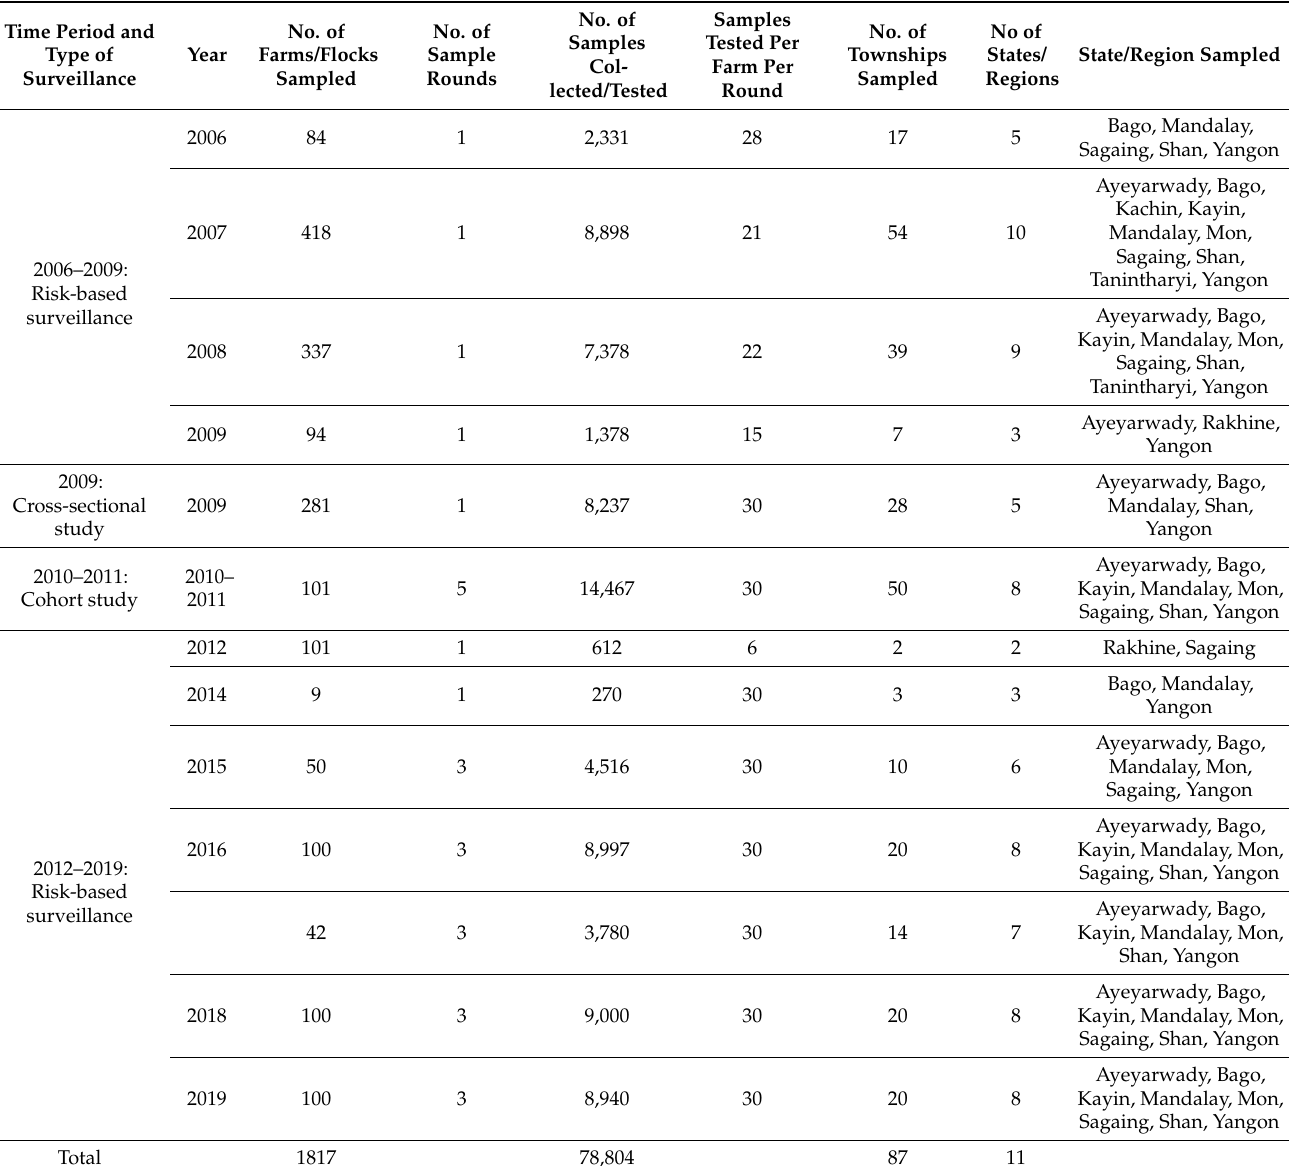
Table 2. Overview of duck sero-surveillance from 2006 to